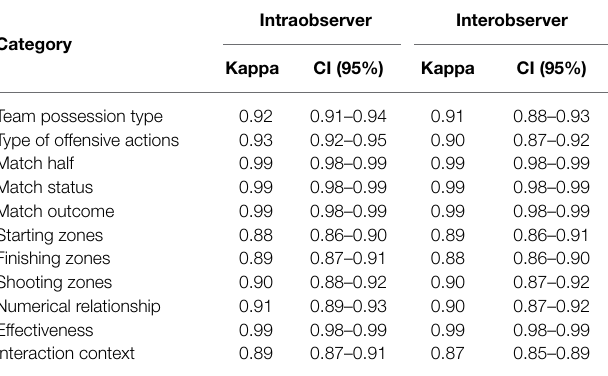
TABLE 3 | Kappa values for intraobserver and interobserver.